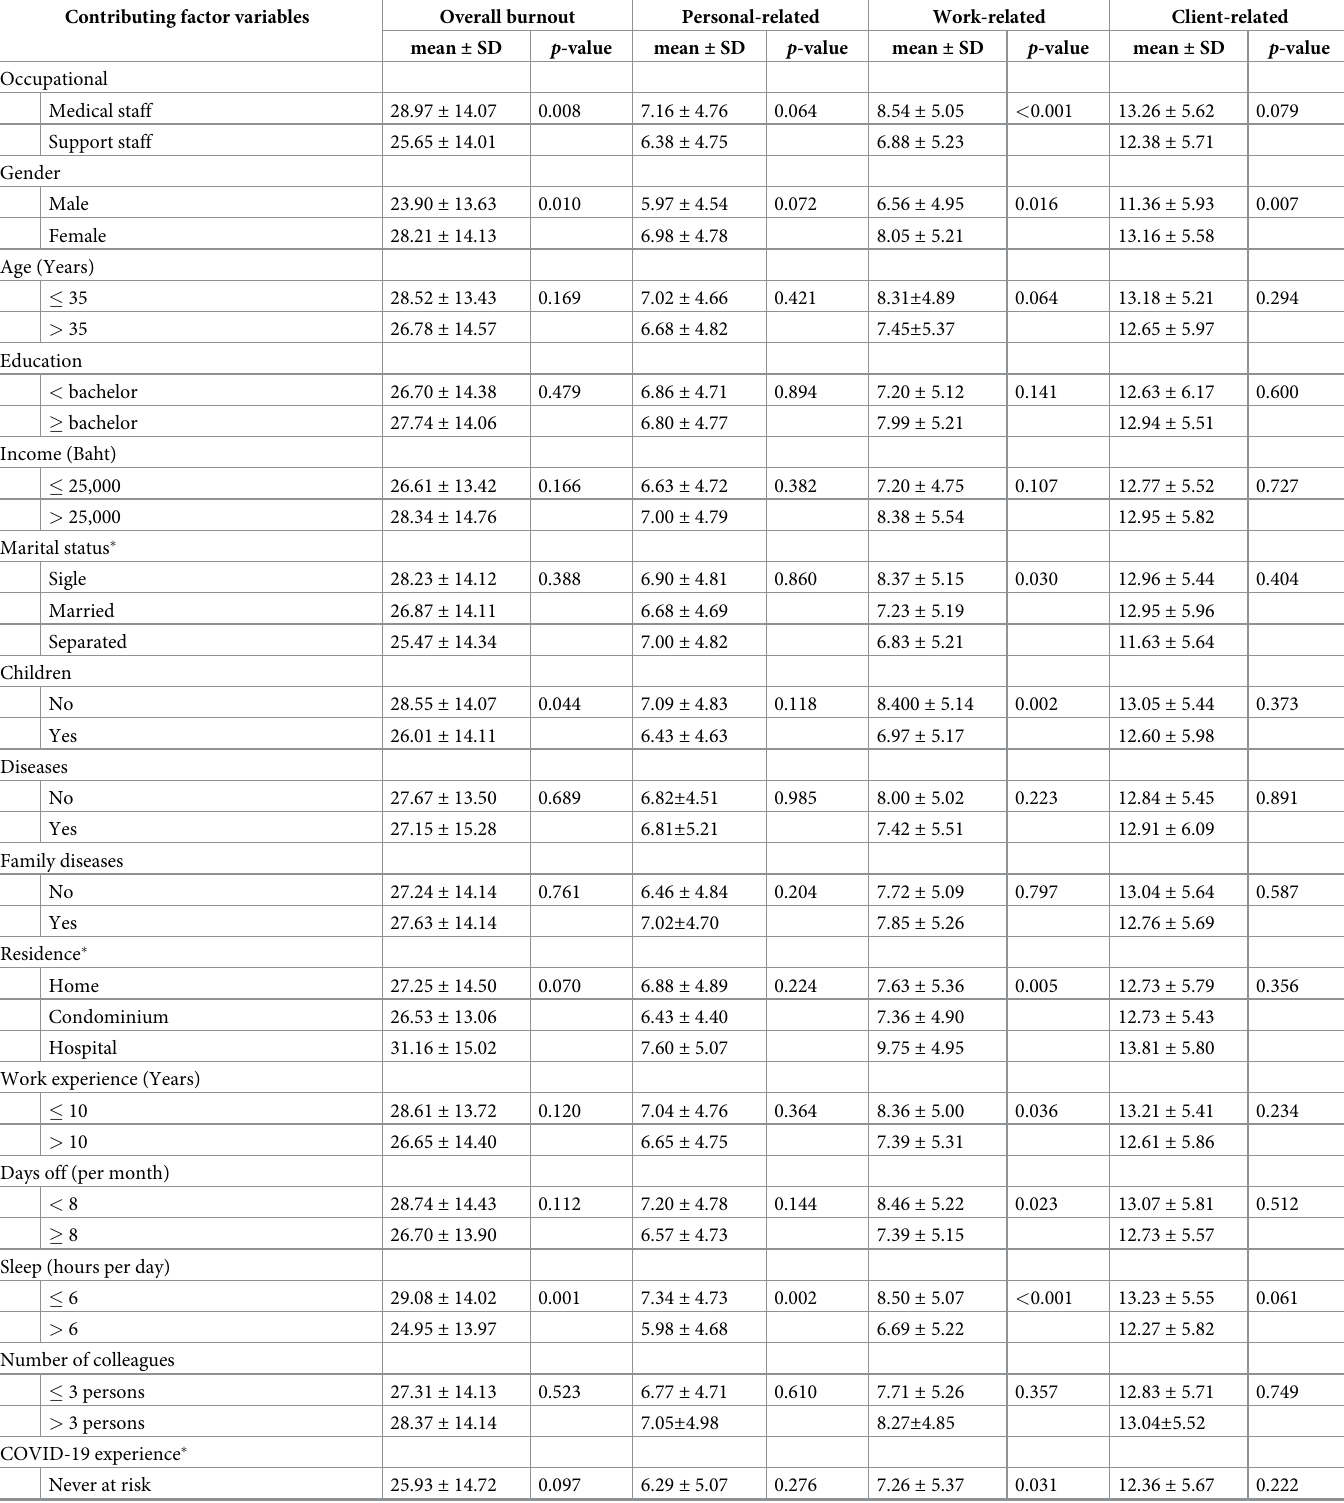
Table 3. Comparison between contributing factors and